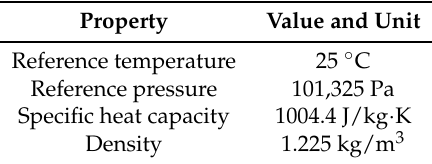
Table 1. Fluid properties used in computational fluid dynamics (CFD) simulation.